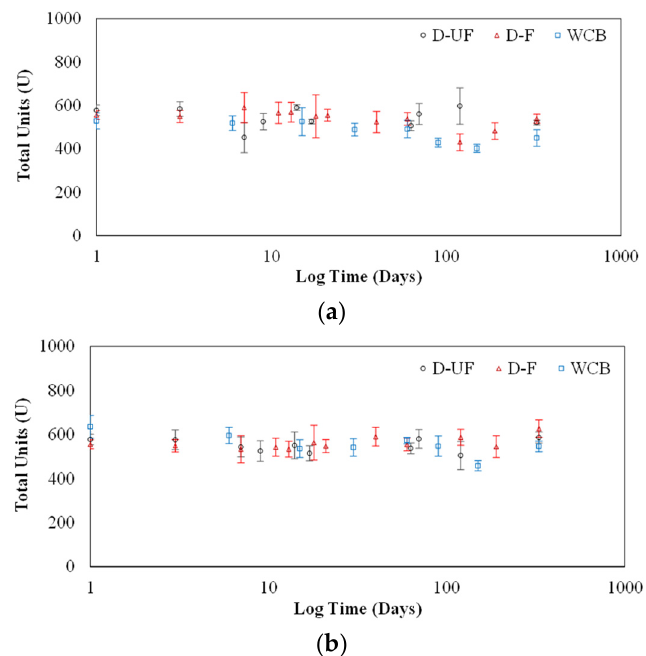
Figure 4. Urease activity measurements in units determined at different storage times for different sources of lyophilized prepared crude extract at ( a ) RT and ( b ) 4 °C. (D-UF) Dehusked Unfiltered, (D-F) Dehusked Filtered, (WCB) Whole Crushed Beans.